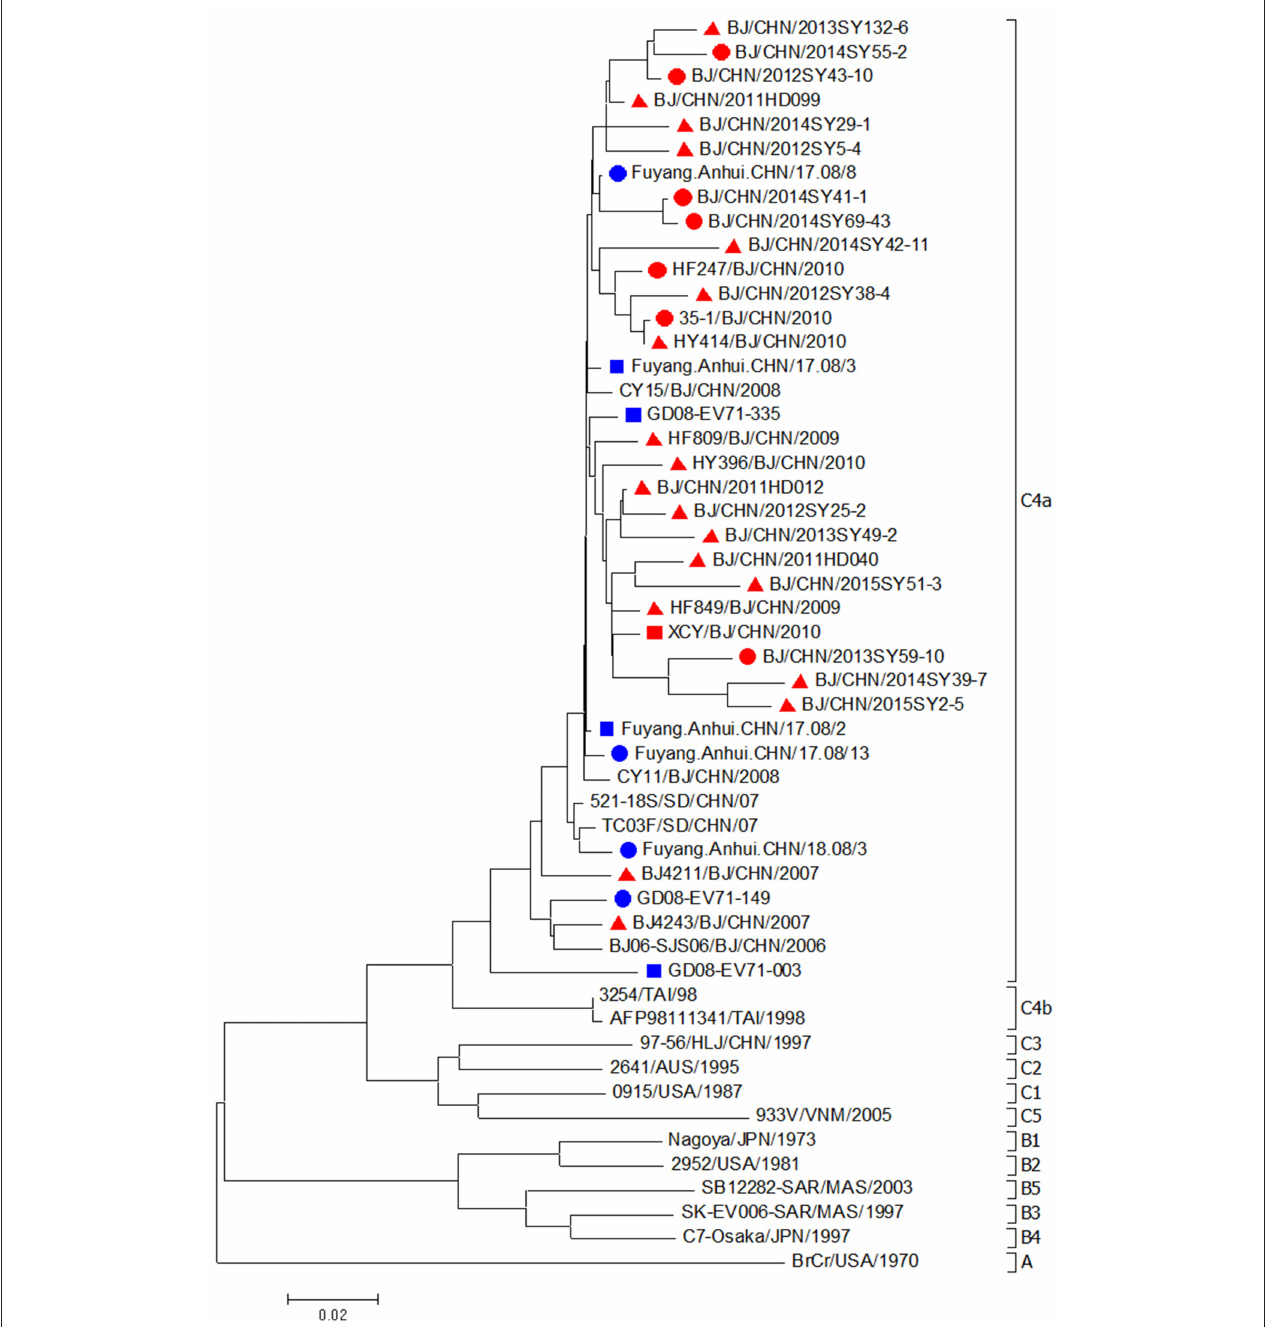
FIGURE 3 | Phylogenetic dendrogram based on the alignment of the complete VP1 gene sequence of EV71 (891bp). EV71 strains isolated from mild cases, severe cases and fatal cases in Beijing were indicated by a red triangle, a red dot and a red square, respectively. EV71 strains isolated from severe cases and fatal cases in other cities were indicated by a blue dot and a blue square,